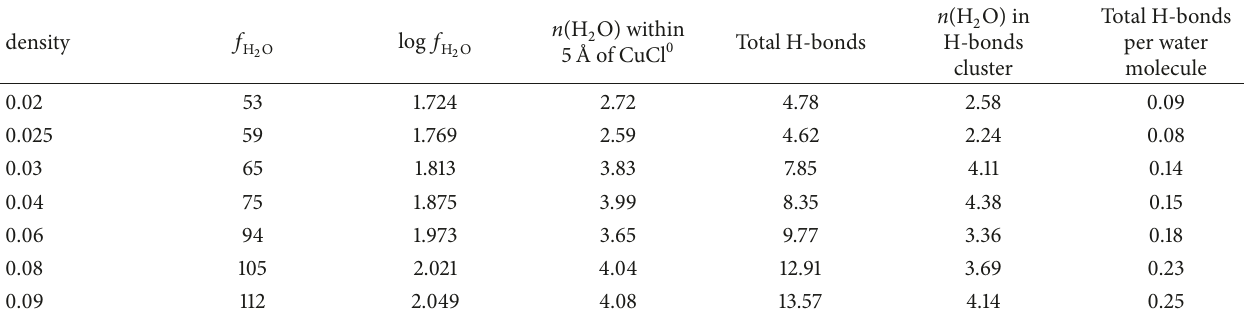
n (H 2 O) within log 𝑓 H 2 O 2 O 5 ˚A of CuCl 0